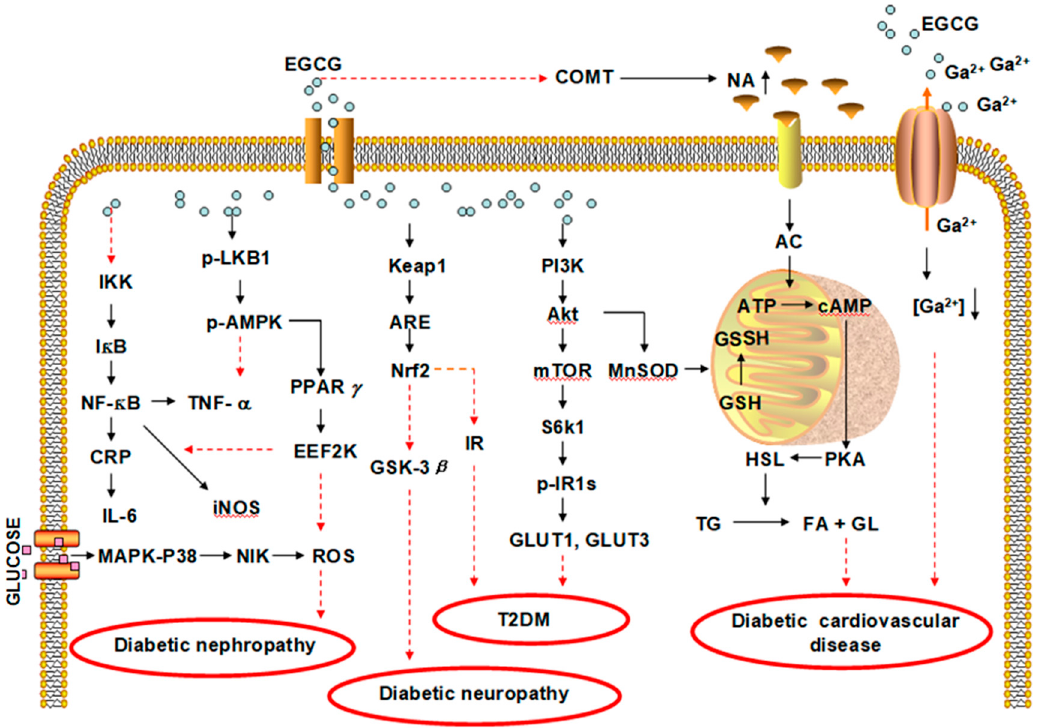
Figure 2. The molecular mechanisms of EGCG against diabetes mellitus and its complications. EGCG has shown effects against T2DM by improving IR, against diabetic cardiovascular disease by decreasing TG and [Ga 2+ ], against diabetic nephropathy by decreasing ROS and against diabetic neuropathy by increasing Nrf2. The arrow means the direction of actions, and the black full lines indicate upregulation and red dotted lines refer to downregulation or inhibition. CRP, C-reactive protein; MAPK p38-NIK, NF- κ B inducing kinase; LKB1, kelch-like ECH-associated protein-1; EEF2K, eukaryotic elongation factor-2 kinase; ARE, antioxidant-responsive element; GSK-3 β , glycogen synthase kinase-3 β ; IR, insulin resistance; MnSOD, Mn superoxide dismutase; NA, noradrenalin; s6k1, ribosomal protein S6 kinase 1; AC, adenylate cyclase; HSL, hormone-sensitive lipase; TG, triglyceride; FA, fatty acid; GL, glycerinum; GSH, glutathione; GSSH, oxidized glutathione; mTOR, the target of rapamycin; EGCG, epigallocatechin gallate; IKK, I κ B kinase; NF- κ B, nuclear factor- κ B; iNOS, inducible nitric oxide synthase; TNF- α , tumor necrosis factor- α ; Nrf2, nuclear factor-erythrocyte-associated factor 2; PI3K, phosphatidylinositol 3-hydroxykinase; Akt, protein kinase B; AMPK, adenylic acid-activated protein kinase; T2DM, type 2 diabetes mellitus; GLUT, glucose transporter type; PKA, protein kinase A; ATP, adenosine triphosphate; cAMP, cyclic Adenosine monophosphate; COMT, catechol-O-methyltransferase, an enzyme responsible for the degradation of noradrenalin.